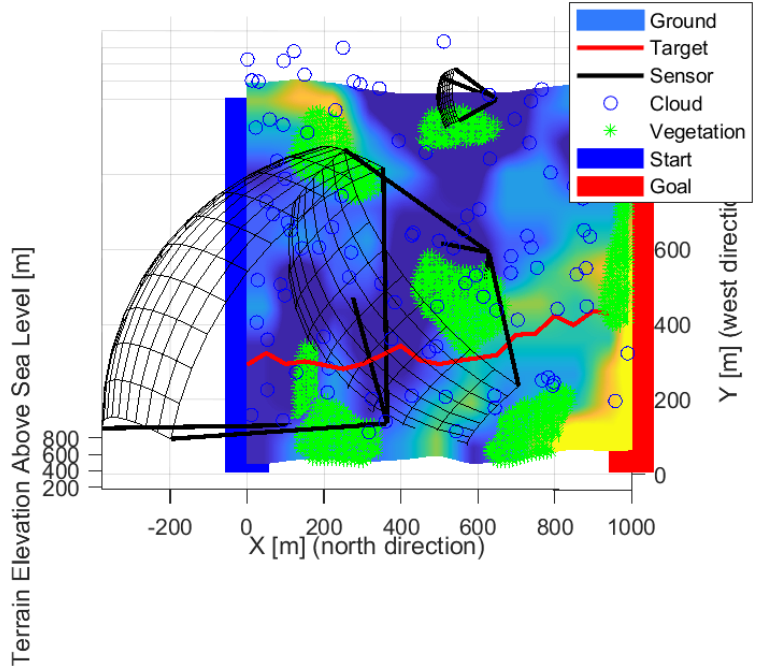
Figure 11. The solution in the case of the three sensors from